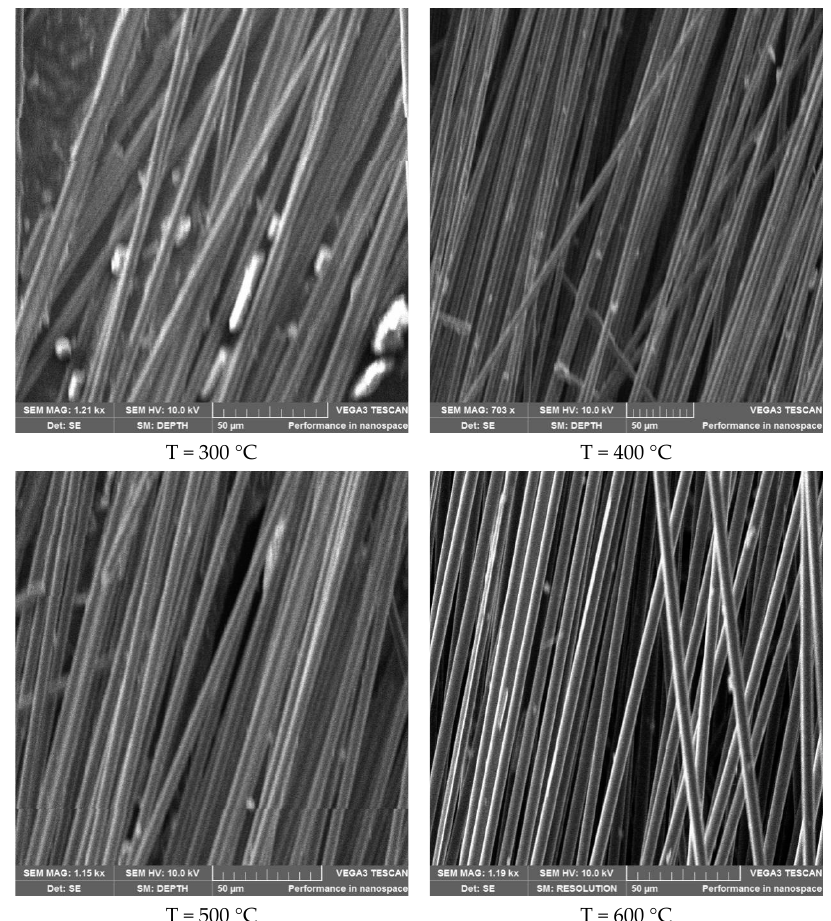
Figure 9. Sem images of CFRP plate specimens at different